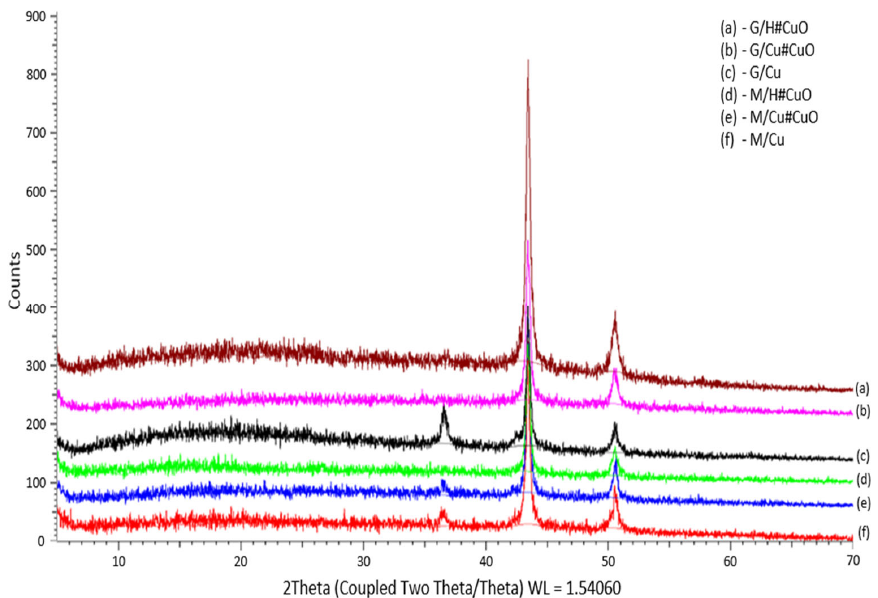
Figure 8. XRD patterns of residues in N 2 .